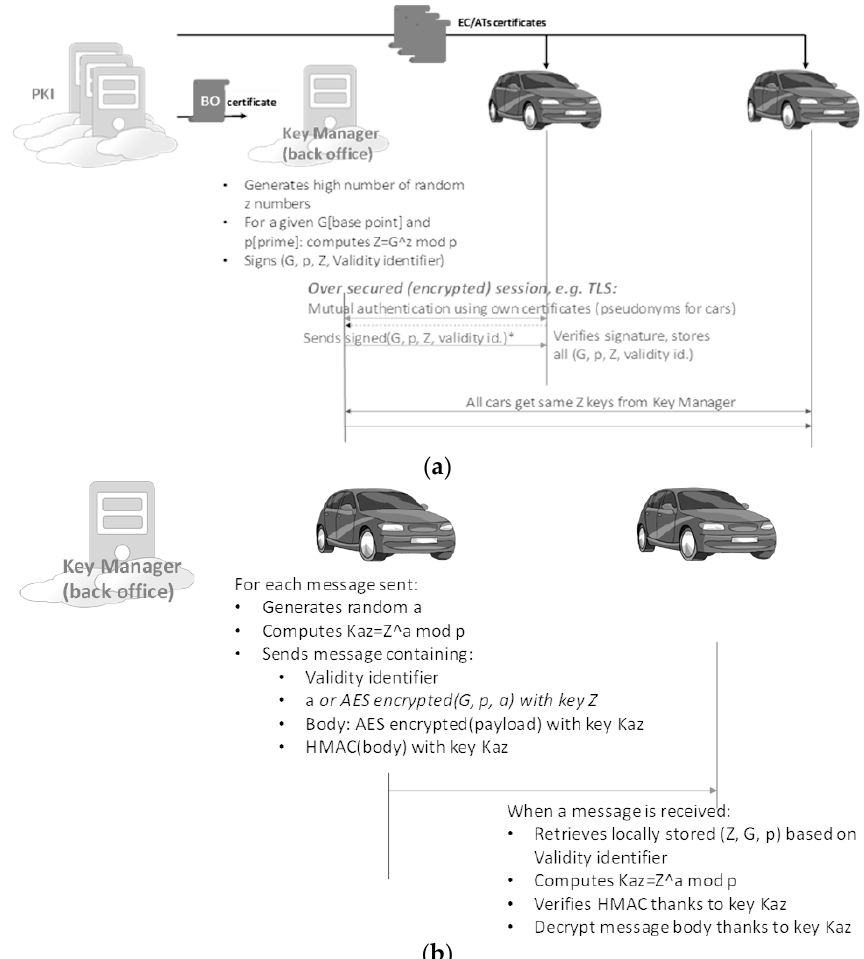
Figure 4. ( a ) Vehicle gets shared keys from the back-office Key Manager and ( b ) anonymous messages exchange between vehicles.